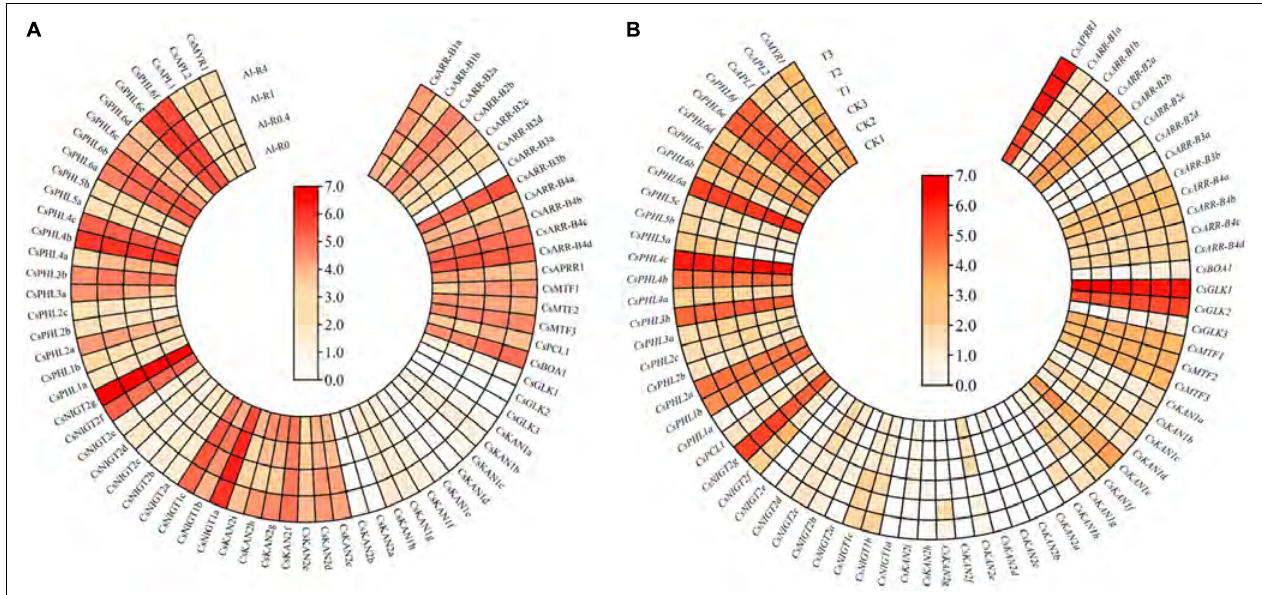
FIGURE 12 | Expression analysis of CsGARPs under Al treatment (A) and Acaphylla theae attack (B) . The expression levels of CsGARPs were calculated with TPM values. The red and blue colors represent high and low expression levels, respectively.